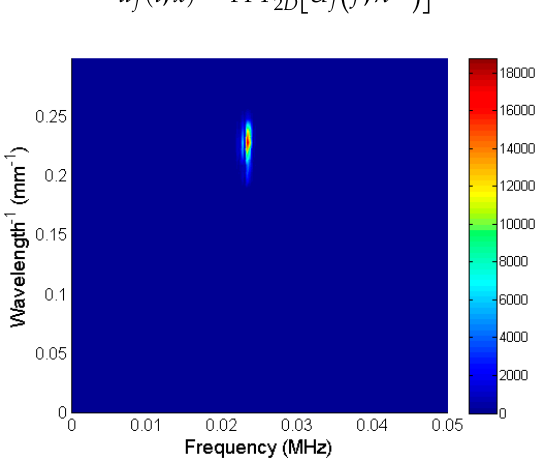
Figure 12. 2D spatial–temporal spectrum of recorded B-scan after filtering. The filtered B-scan is shown in Figure 13a. The A-scan signal taken from the filtered B-scan at a distance of 37.5 mm is shown in Figure